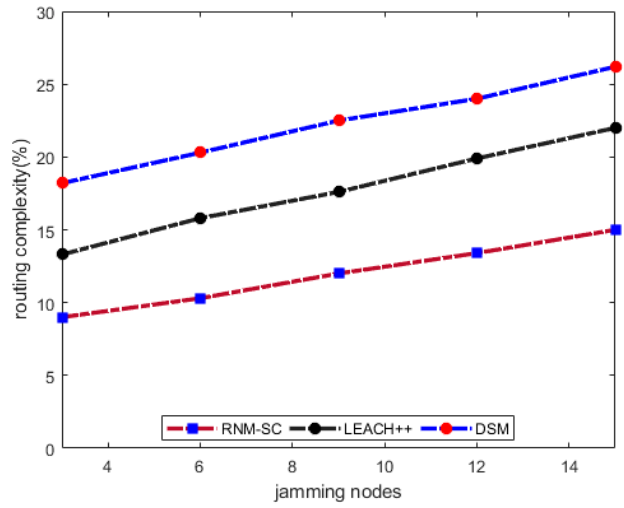
Figure 7. Routing complexity and jamming nodes.